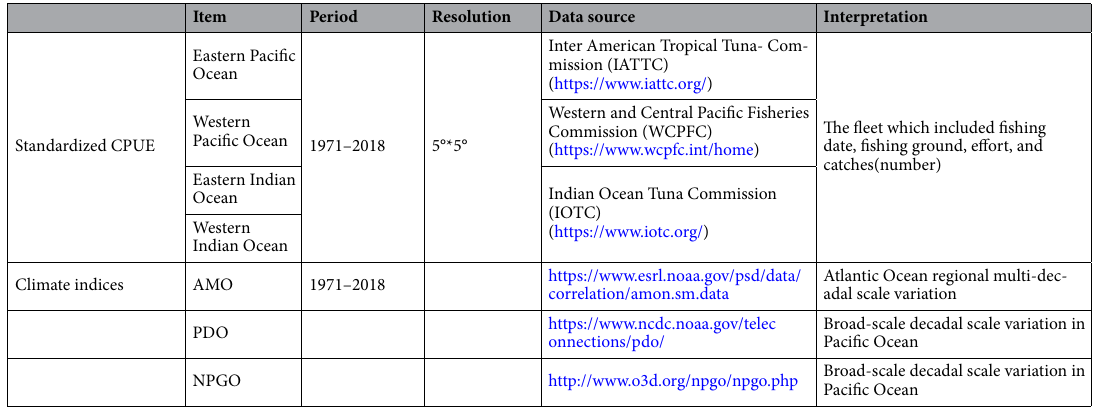
Table 2. Sources and specifications of global standardized CPUE, and climate index